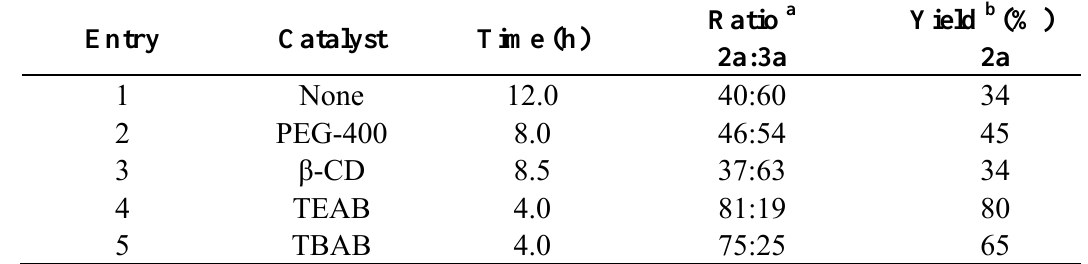
Table 4. The effect of catalysts on the monohydrolysis of 1a using 1.2 equivalents of NaOH.